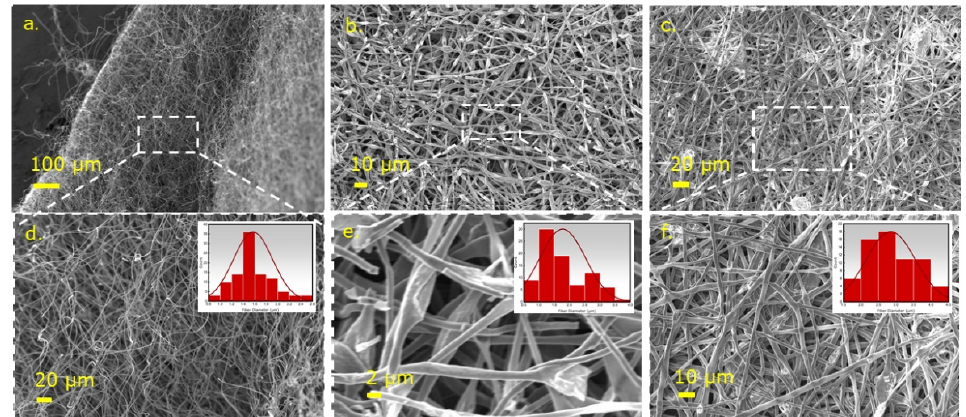
Figure 2. SEM images of ( a ) PVP fiber mat carbonized at 800 °C, ( b ) PVP/SiOC fiber mat pyrolyzed at 8000 °C, ( c ) PVP/SiOC/MoSe 2 fiber mat pyrolyzed at 8000 °C, and ( d – f ) corresponding high-magnification images of these fiber mats (inset shows diameter distribution of the fibers).